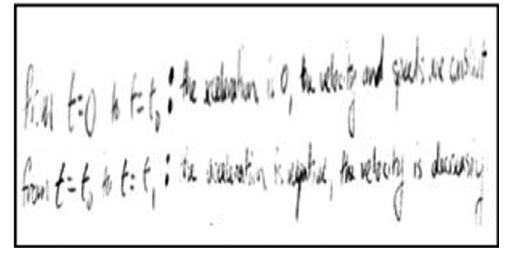
FIG. 9. Interpretation of acceleration-time graph (question 2).